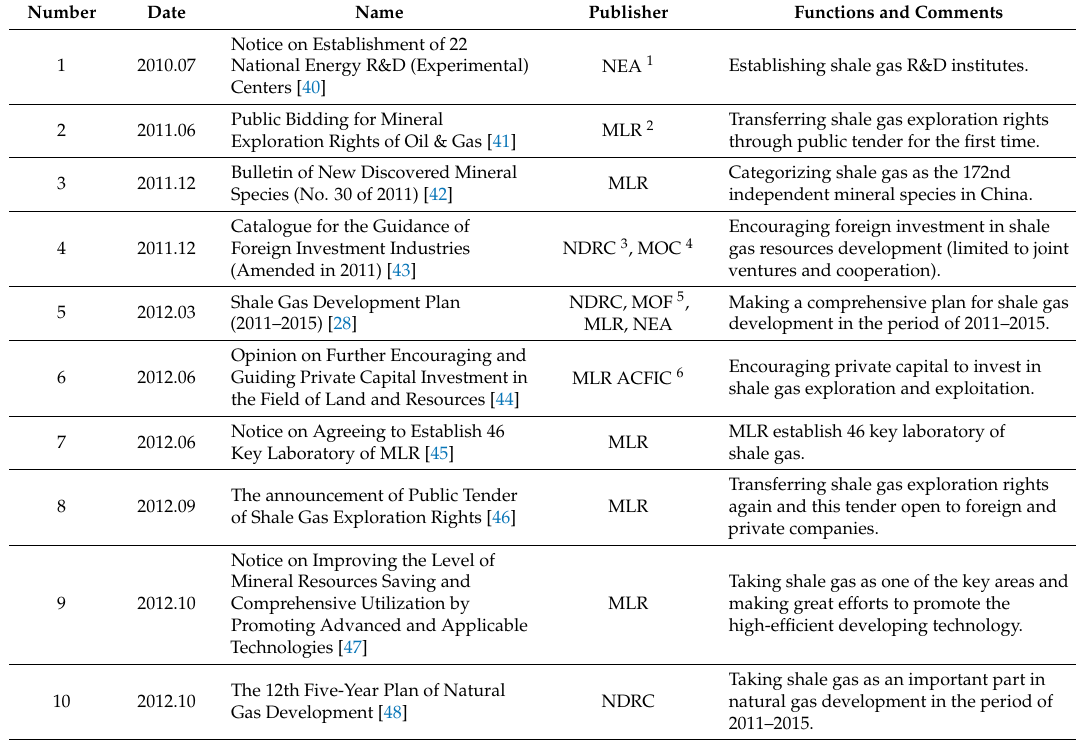
Table 1. Shale gas-relevant policies in